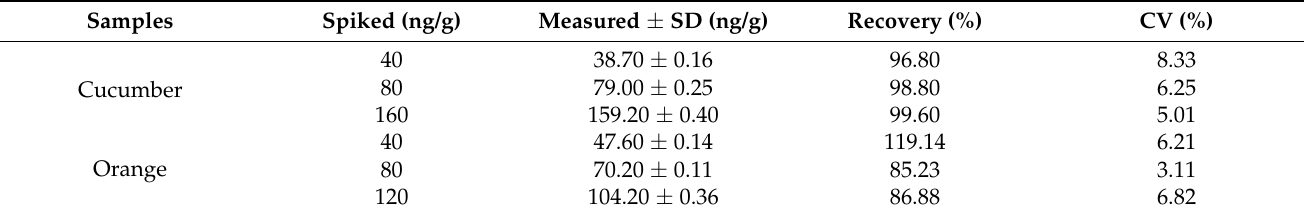
Table 3. Recoveries of CPPU-spiked food samples determined by icELISA ( n = 3). Samples